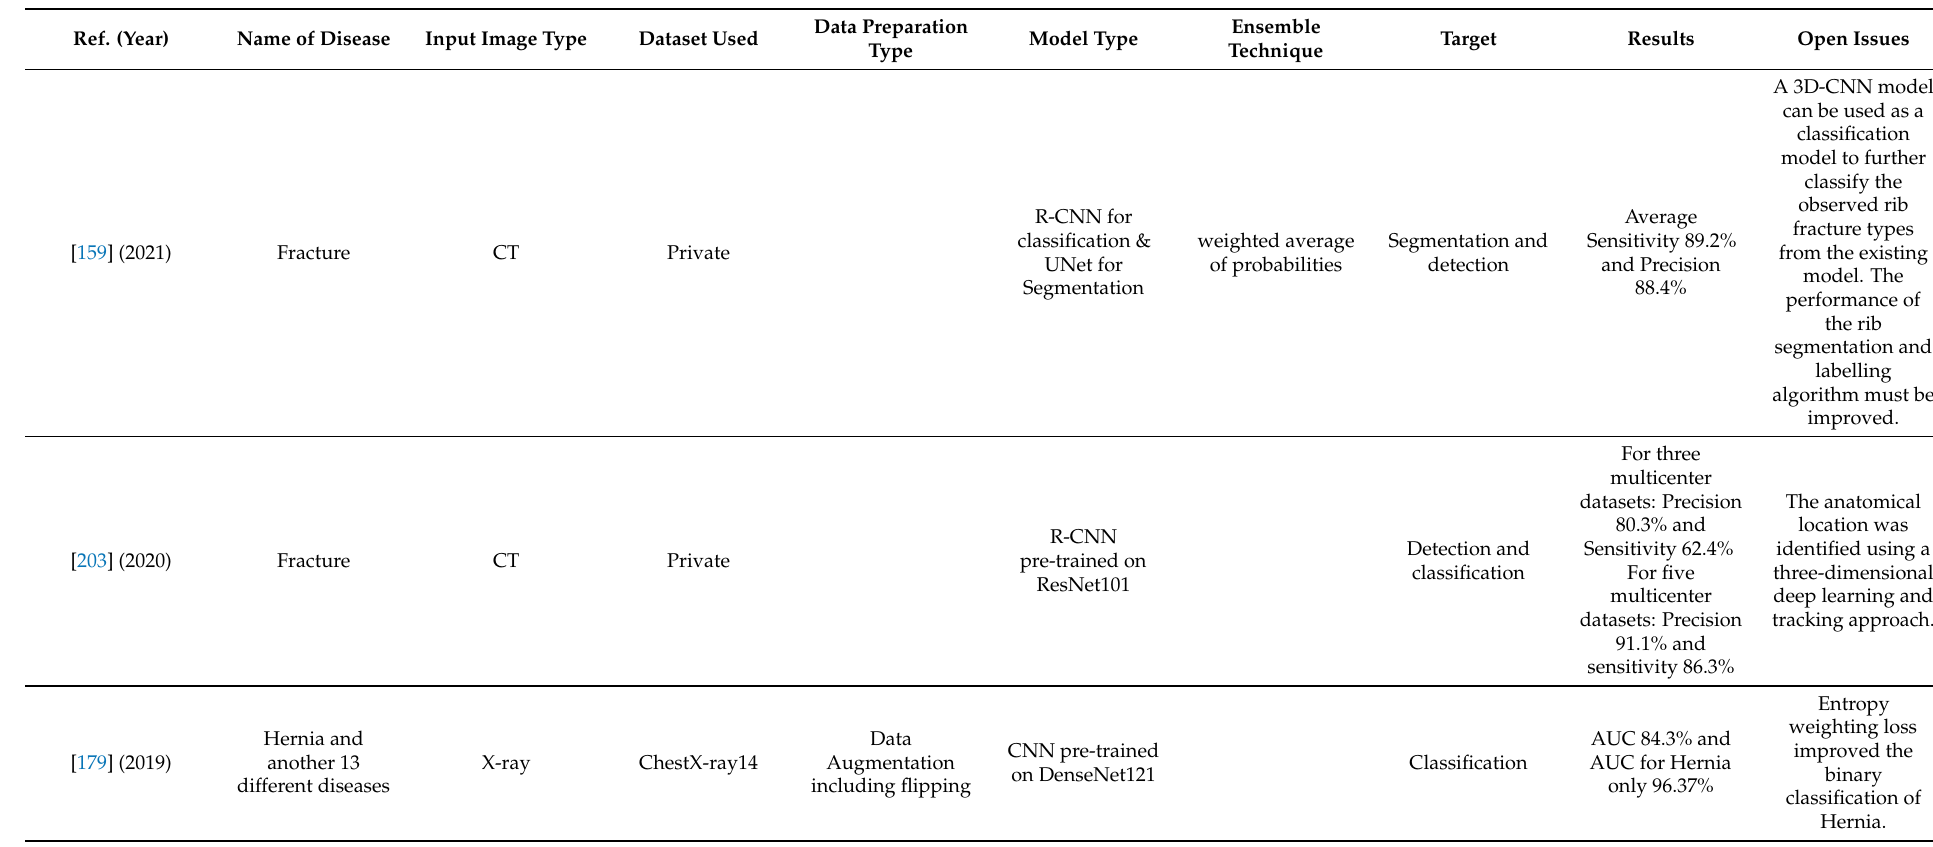
Table 7. Other diseases’ detection